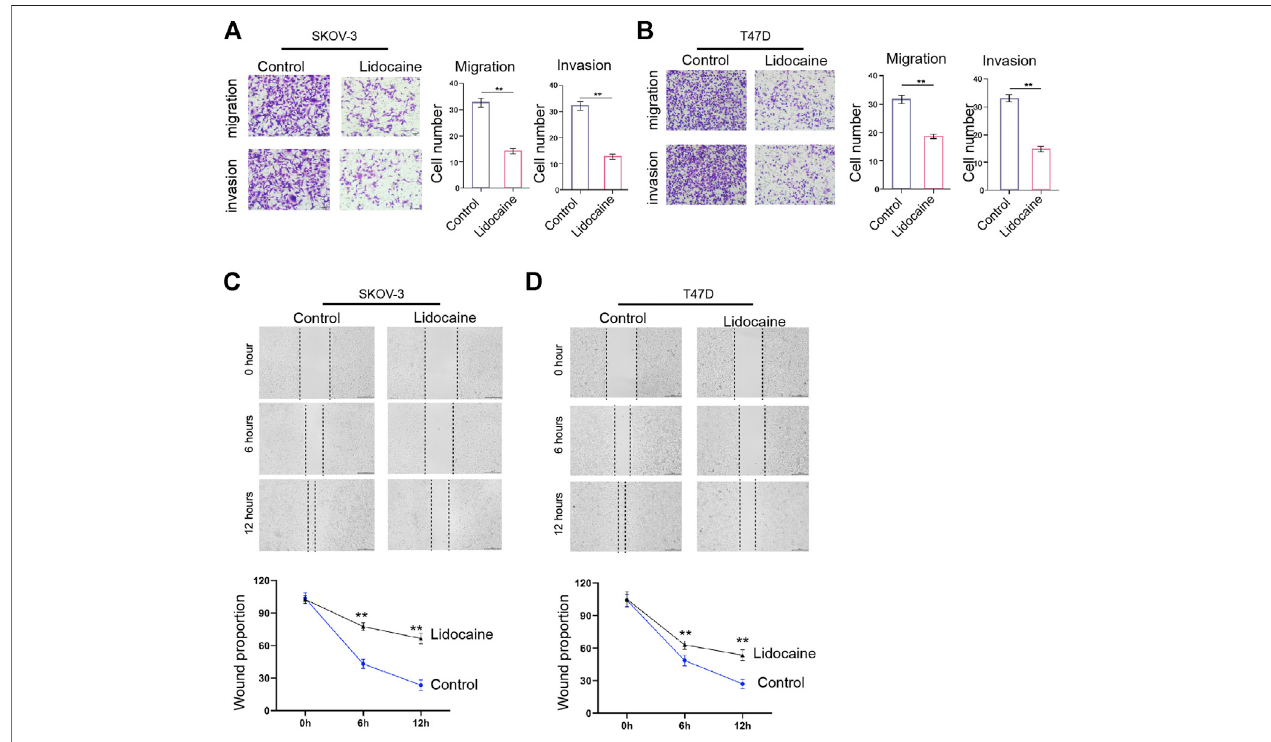
FIGURE 3 | Lidocaine suppresses invasion and migration of ovarian and breast cancer cells in vitro . (A – D) SKOV-3 and T47D cells were treated with lidocaine (3 mM). (A,B) The cell invasion and migration were measured by transwell analysis. (C,D) The cell migration was analyzed by wound healing analysis. mean ± SD, ** p < 0.01. The experiments were performed independently three